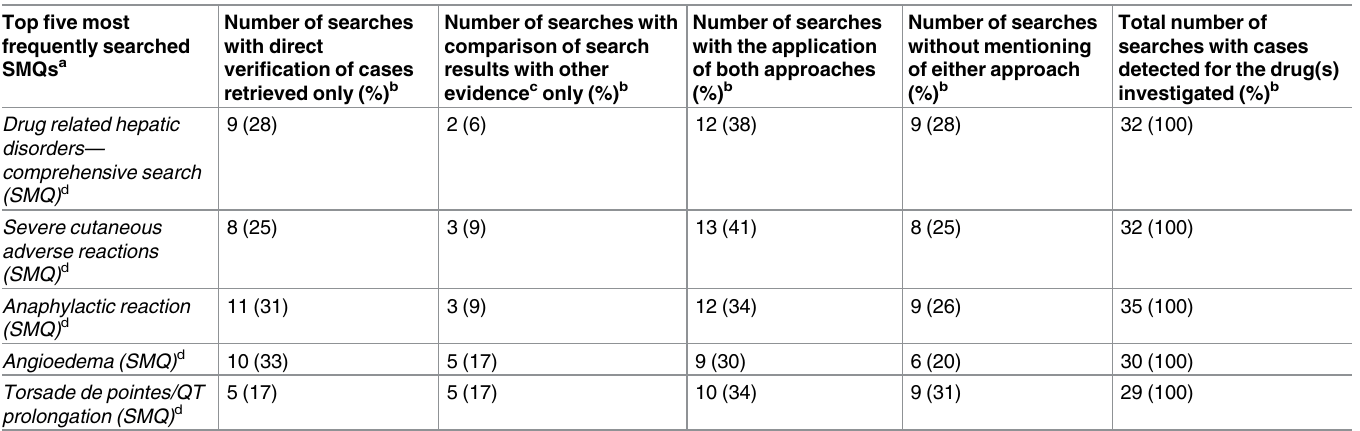
Table 3. Confirmation approaches used for top five most frequently searchedSMQs.